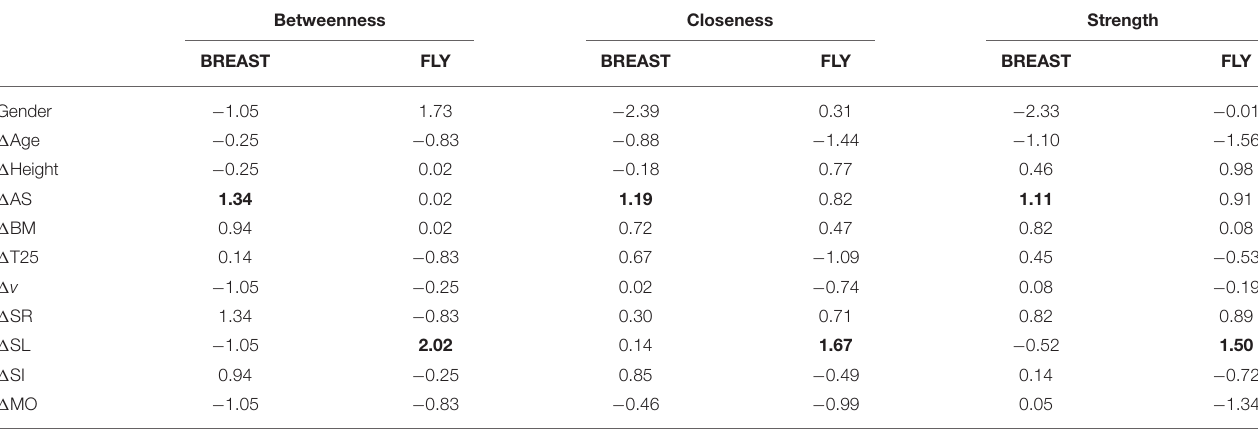
TABLE 4 | BREAST and FLY centrality measures (gender as dichotomous variable) ( n = 20). Betweenness Closeness Strength BREAST FLY BREAST FLY BREAST